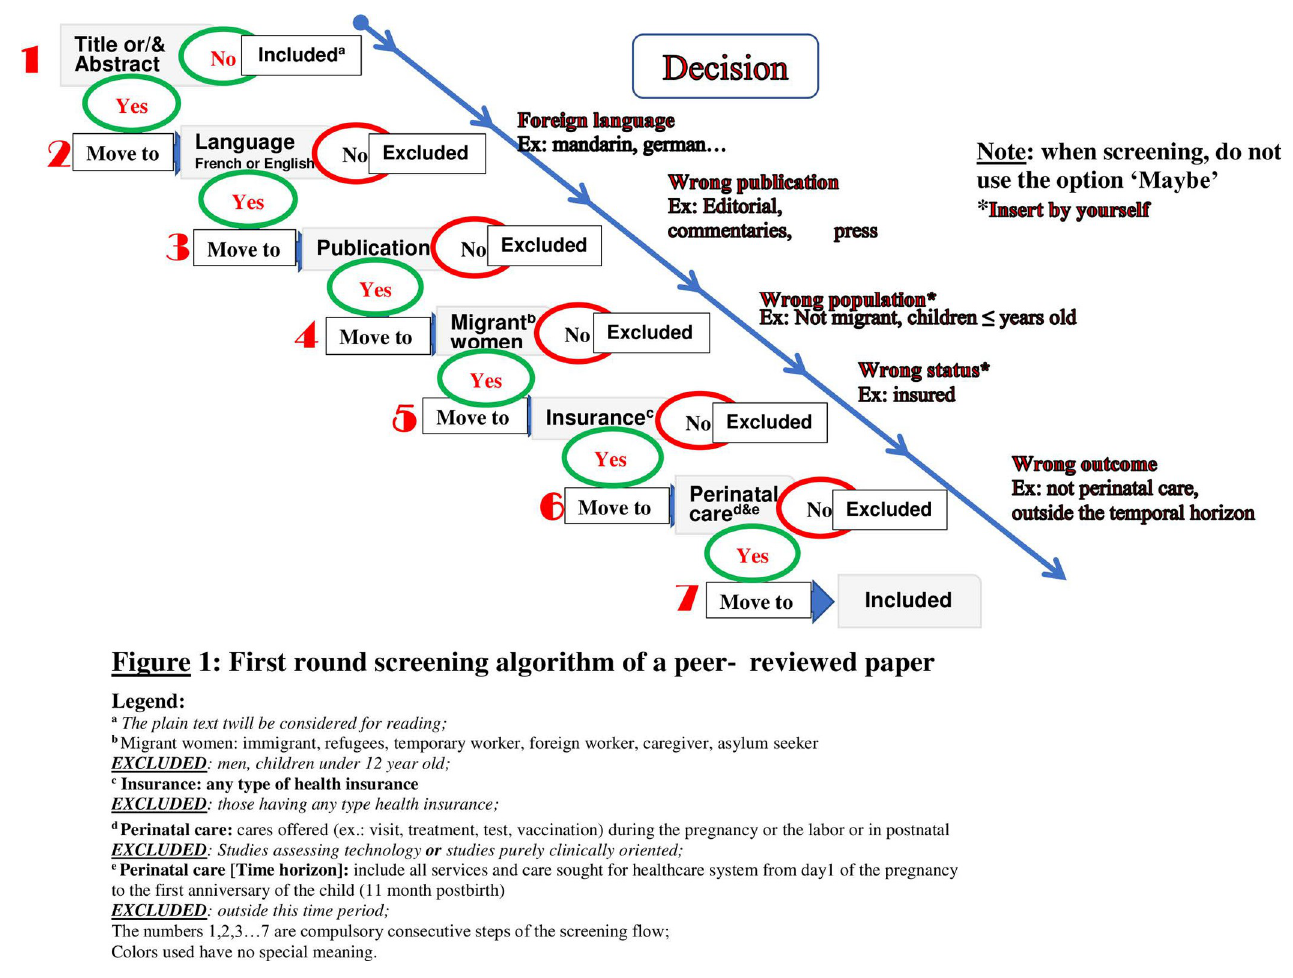
Fig 1. First round screening algorithm of a peer-reviewed